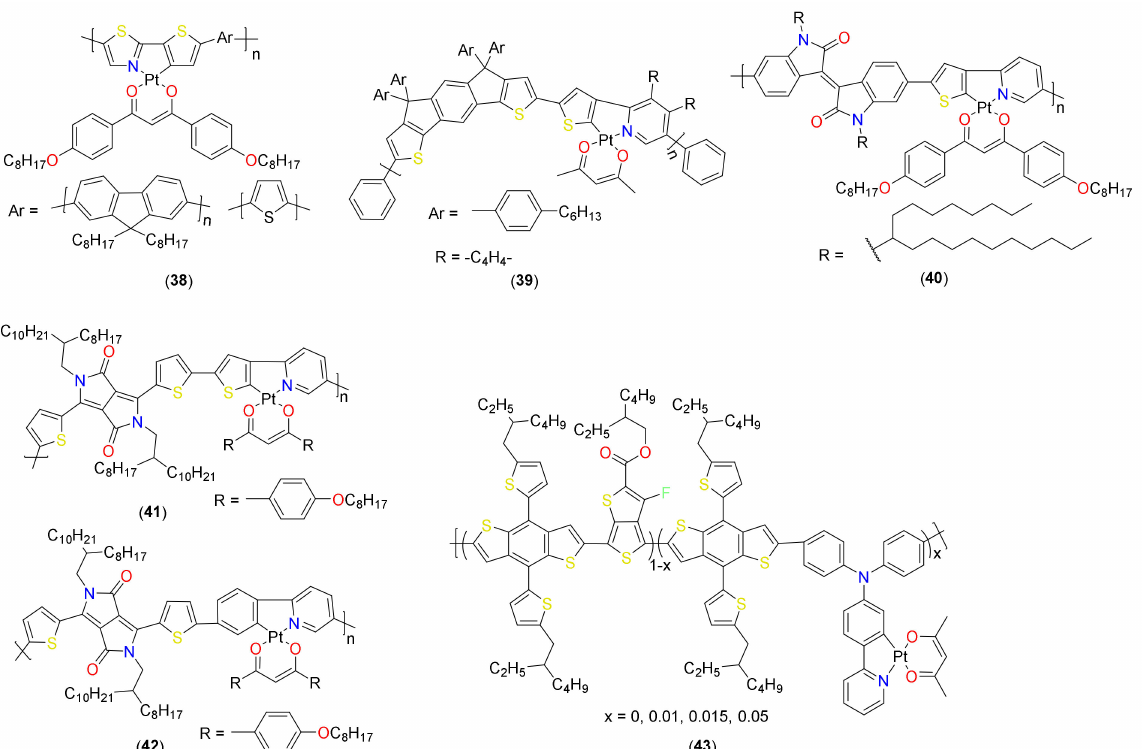
Figure 9. Cyclometalated Pt(II) complexes-based donor